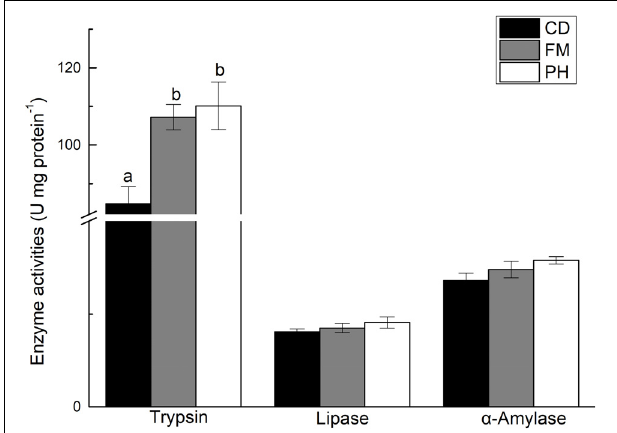
FIGURE 1 | Digestive enzyme activities in hepatopancreas of shrimps fed with different experimental diets for 6 weeks. Results are shown as the mean ± SE. Different letters indicate significant differences ( n = 3; P < 0.05).